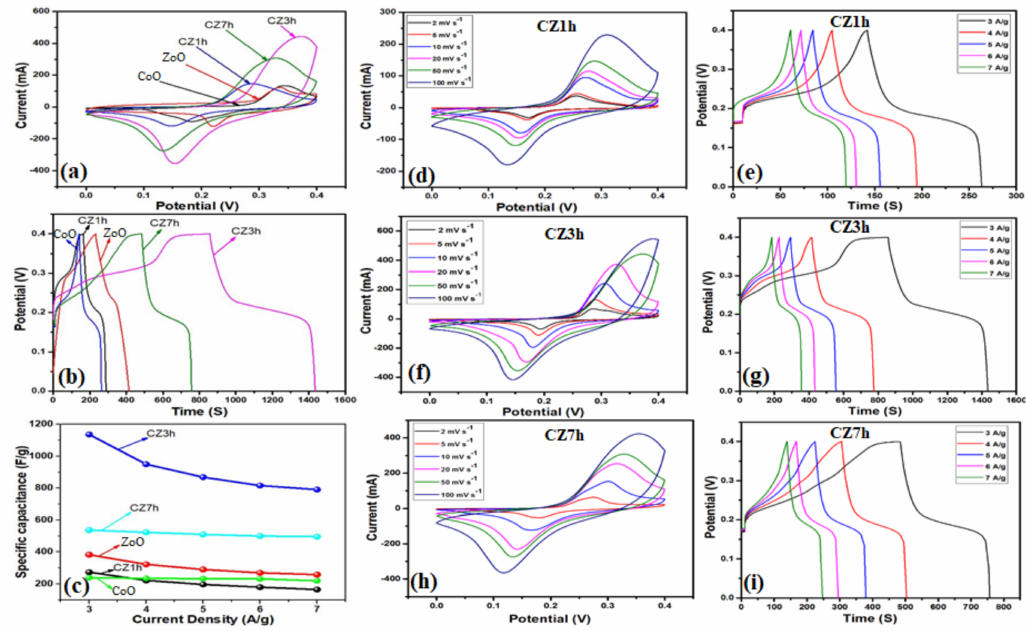
Figure 7. ( a ) Comparative cyclic voltammetry (CV) curves of the CoO, ZnO, CZ1h, CZ3h and CZ7h electrodes at a scan rate of 50 mV s − 1 . ( b ) Comparative galvanostatic charge–discharge (GCD) curves of the CoO, ZnO, CZ1h, CZ3h and CZ7h electrodes at a current density of 3 A/g, ( c ) Specific capacitance vs. current density curve of the as-prepared electrodes, ( d , e ) CV curves and GCD curves of the CZ1h electrodes at various scan rates and current densities. ( f , g ) CV curves and GCD curves of the CZ3h electrodes at various scan rates and current densities. ( h , i ) CV curves and GCD curves of the CZ7h electrodes at various scan rates and current